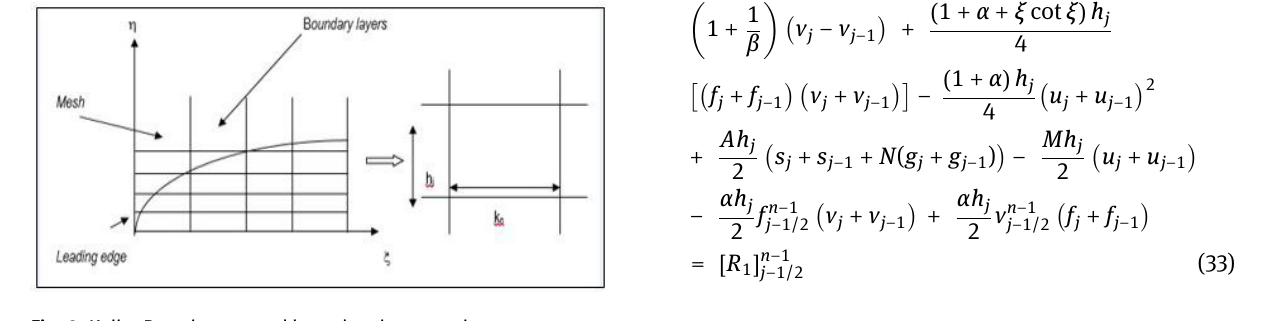
A two-dimensional computational grid (mesh) is im- posed on the ξ-η plane as sketched in Fig. 2. The